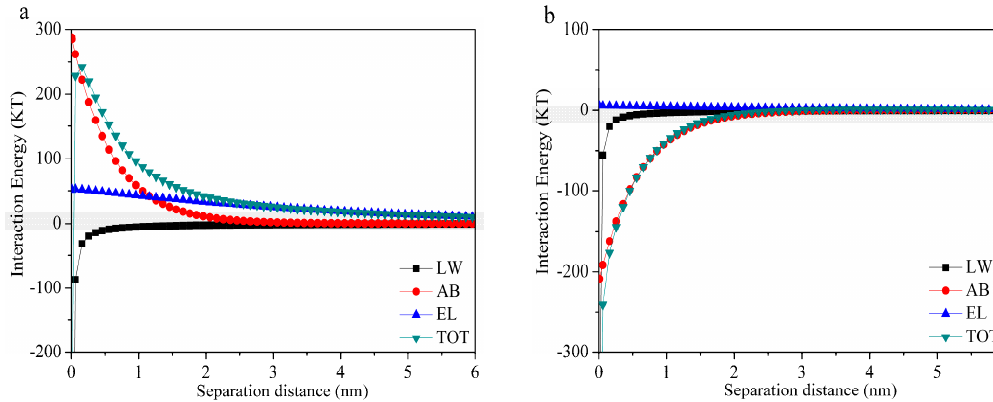
Figure 1. Variation in interaction energy components with separation distance under baseline solution conditions (pH = 7.0, ionic strength (IS) = 10 mM, c(Ca 2+ ) = 0 mM): ( a ) membrane–foulant; ( b ) foulant–foulant.